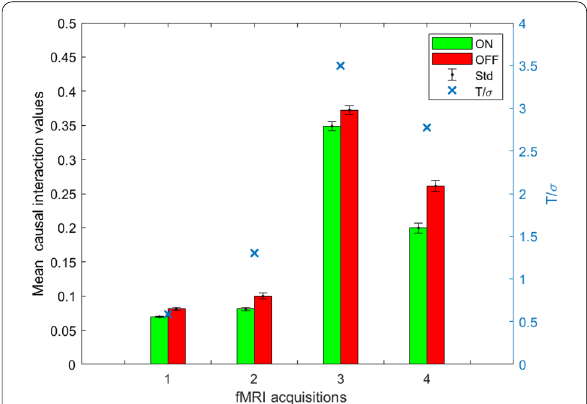
Fig. 9 Comparison between presence (green bar) and absence (red bar) of visual stimulation for the mean a ij coefficient representing the causal influence of MT on V1 in the four different datasets. Bars indicate the mean values and the standard deviation of the mean. Higher values of the coefficients are obtained in data sets with better quality parameter Q , as shown by blue